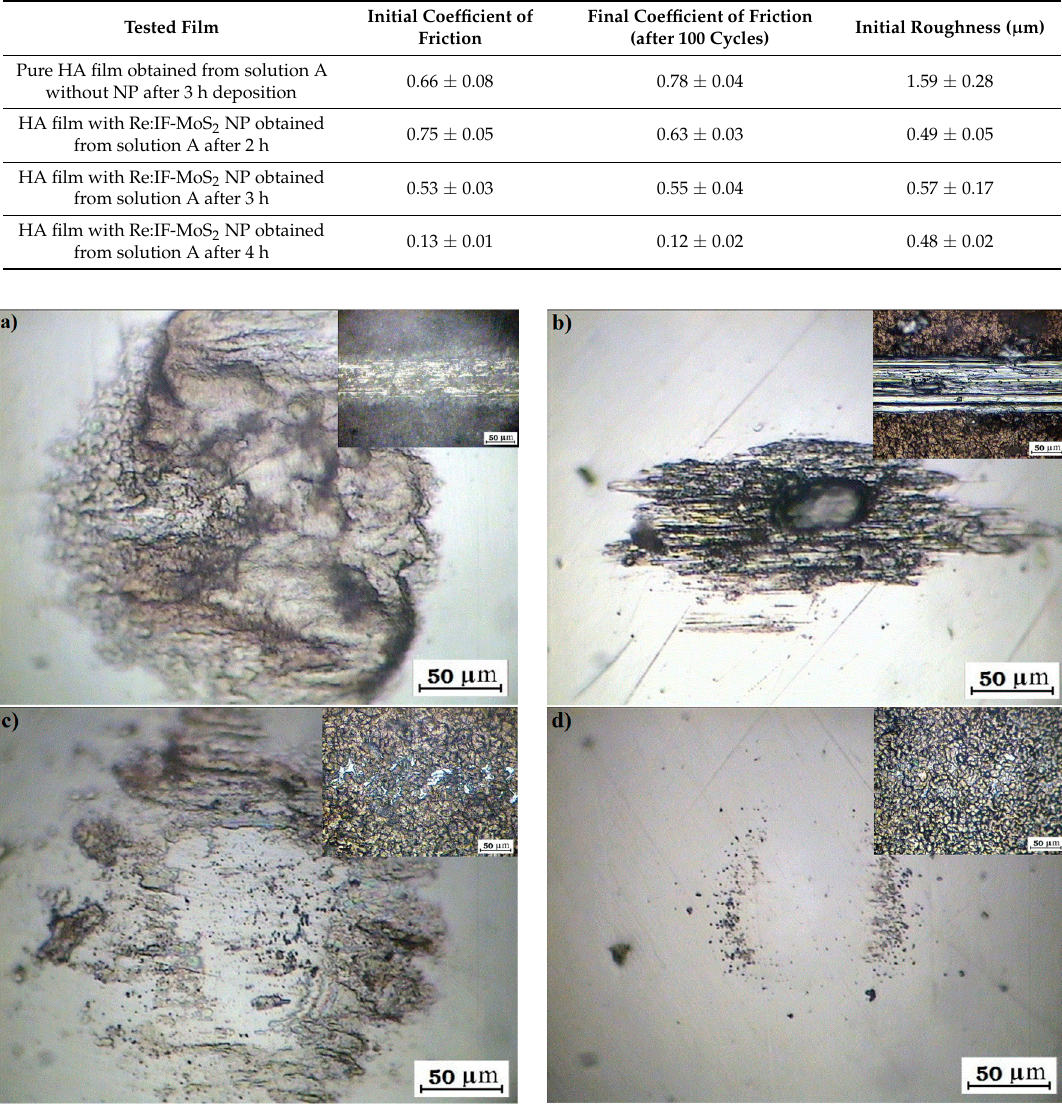
Figure 8. Optical image of wear on the ball and inside the track of HA film without ( a ) and with the Re:IF-MoS 2 nanoparticles obtained from solution A for different periods: after 2 h ( b ), 3 h ( c ) and 4 h ( d ) on anodized titanium.